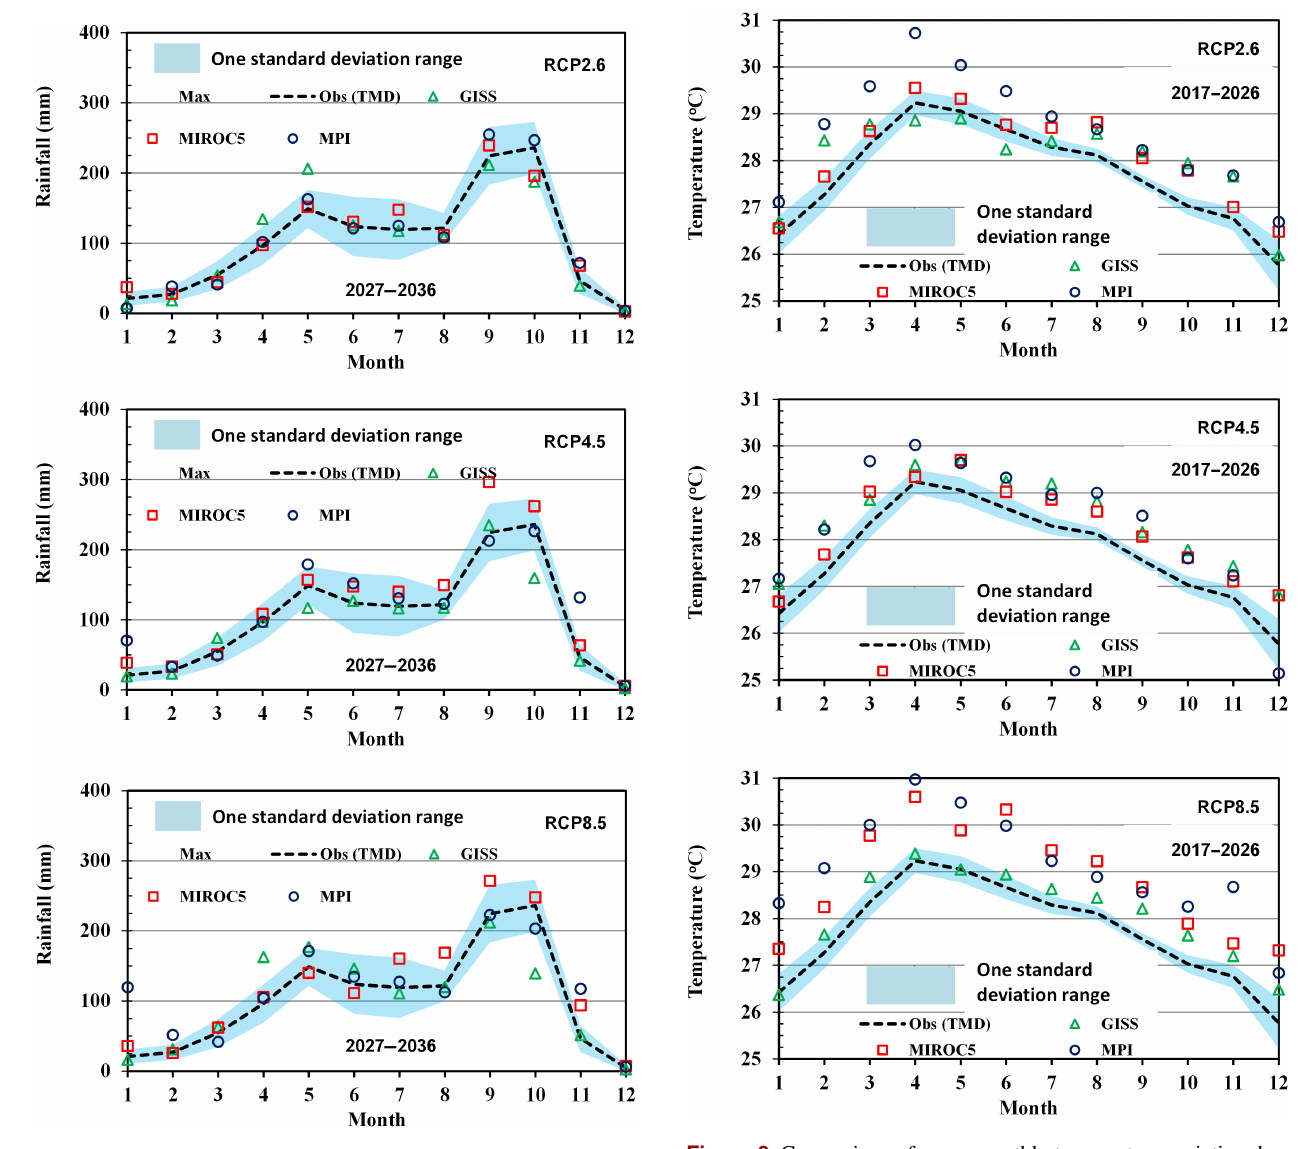
Figure 5. Comparison of mean monthly precipitation variation in 2027–2036 (under the climate change scenarios) and 1991–2000.